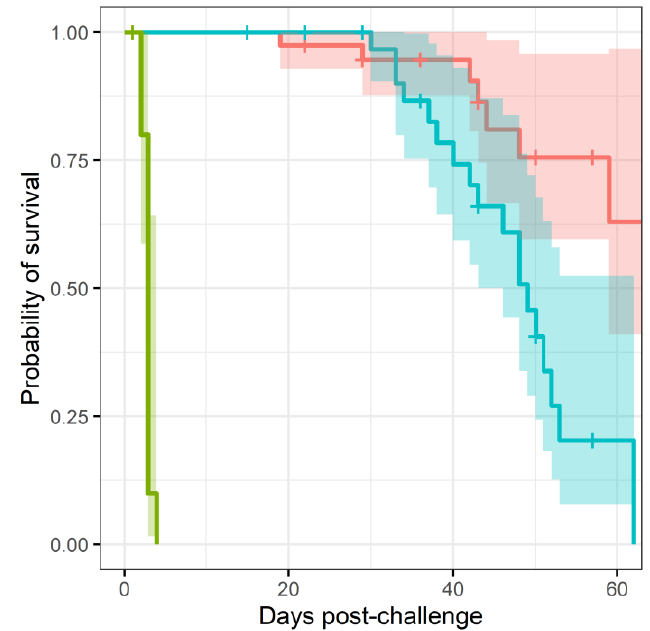
Figure 1. Survival characteristics of mice infected with B. pseudomallei and treated with antibiotics. This plot shows the probability of mice reaching a humane endpoint when treated with finafloxacin (red line), co-trimoxazole (blue line) or untreated and vehicle treated (green line). Mice were infected with a mean retained dose of 142 CFU of B. pseudomallei by the inhalational route and treated with finafloxacin (37.5 mg/kg) every 8 h or co-trimoxazole (78 mg/kg) every 12 h, orally, for 14 days, initiated at 24 h post-challenge. A group of animals were challenged and treated with the vehicle every 8 h. The crosses indicate the scheduled cull points. The shaded regions indicate the 95% confidence region. Supplemental Figure S1 is a diagnostic plot for this analysis.